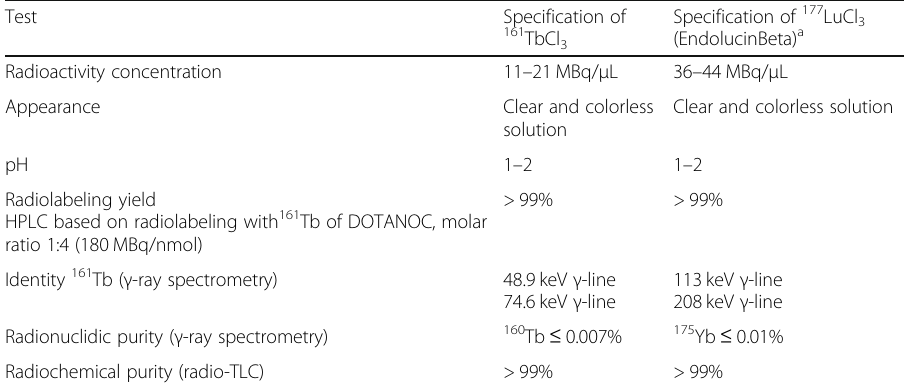
Table 3 Product data specification of 161 TbCl 3 , developed in this work, compared to the commercially-available 177 LuCl 3